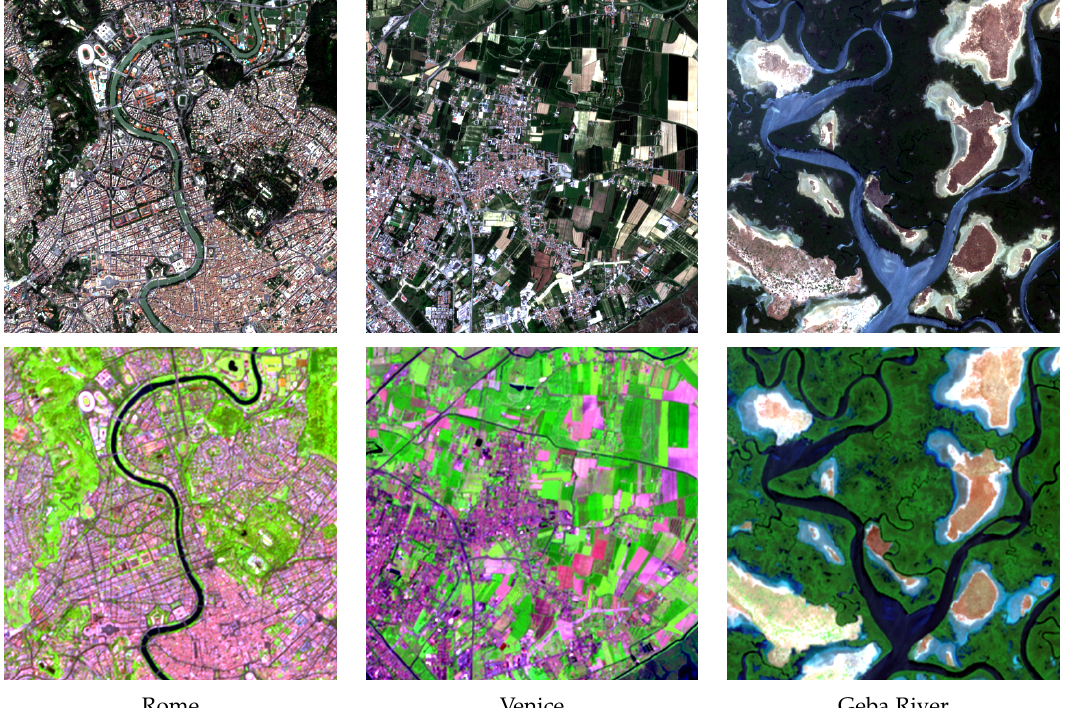
Figure 2. Examples of images used for training. (top) RGB-composite images using 10 m bands B4(R), B3(G) and B2(B), subset of z ; and (bottom) corresponding 20 m RGB subset of x , using B5(R), B8a(G) and